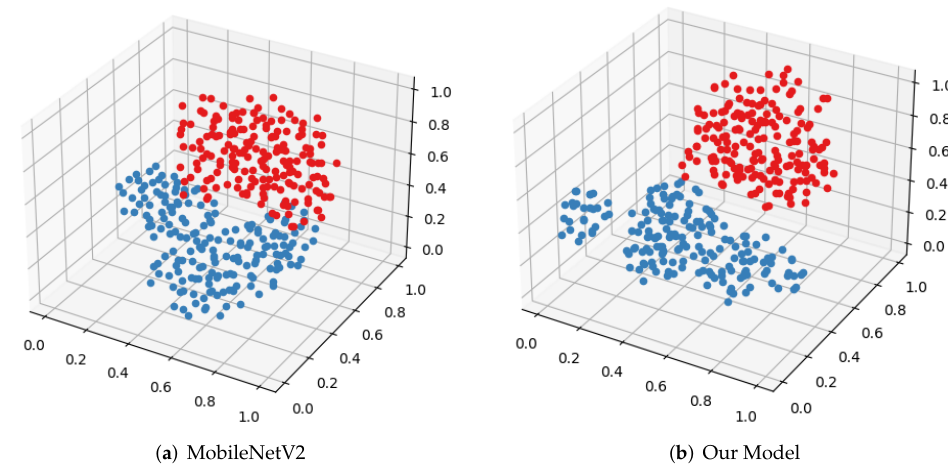
Figure 3. Visualization of the classification results on the PaperNet_2 dataset. (Red: NLP; Blue: CV.)